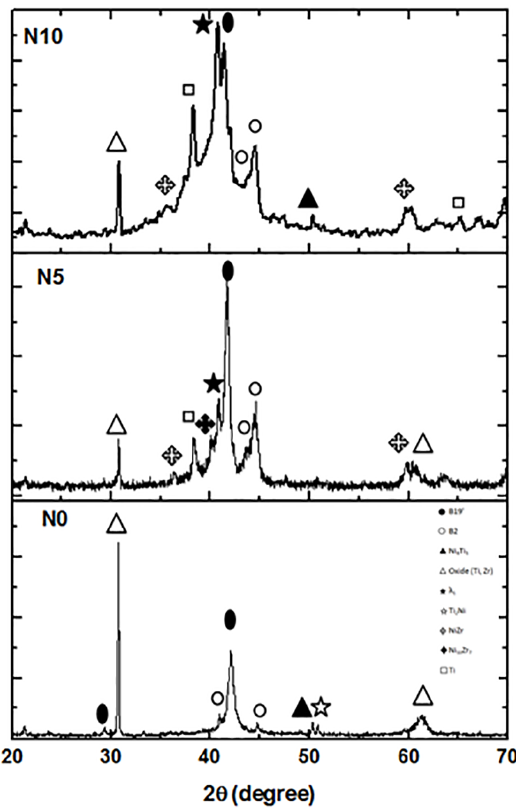
Figure 1. Diffractograms of the alloys N0, N5 e N10. Table 2. Phase Transformation